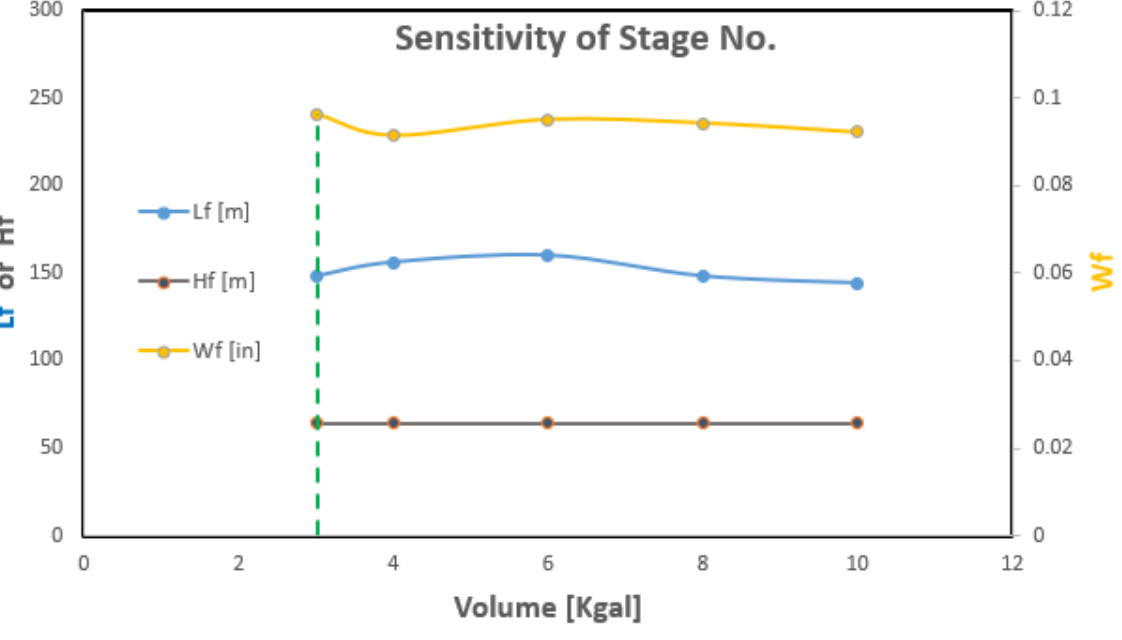
Figure 10. Finding optimized number of stages for 90 K-gal injection volume and 18 BPM injection rate.